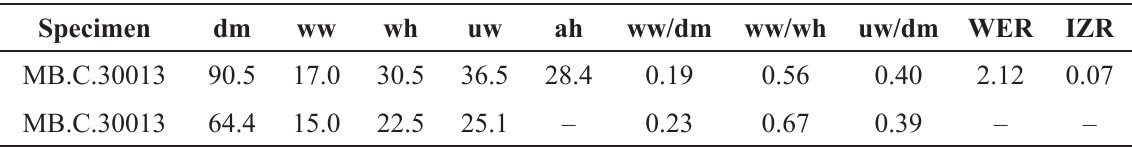
Table 28. Conch dimensions (partly estimated) and ratios of the holotype of Lutites alius Korn & Hairapetian gen. et sp. nov. from Baghuk